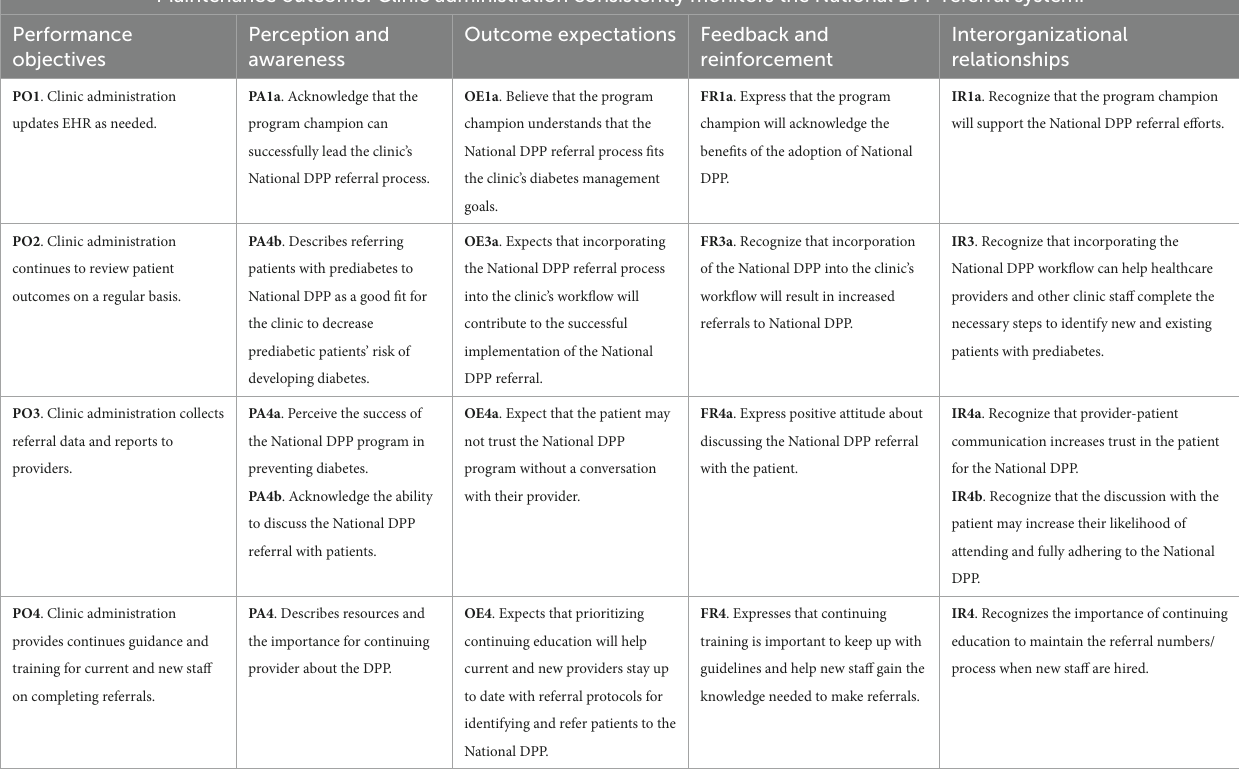
TABLE 5 Sample matrices of change objectives for the maintenance of the National Diabetes Prevention Program among participating clinics in Texas, United States. Maintenance outcome: Clinic administration consistently monitors the National DPP referral